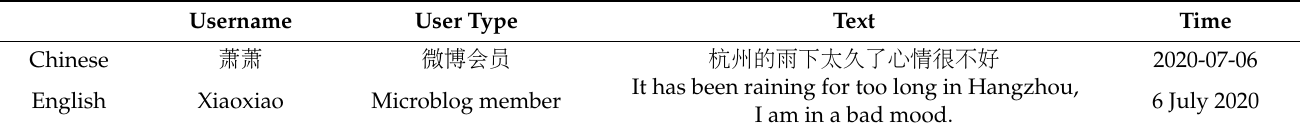
Table 3. One case of microblog data.